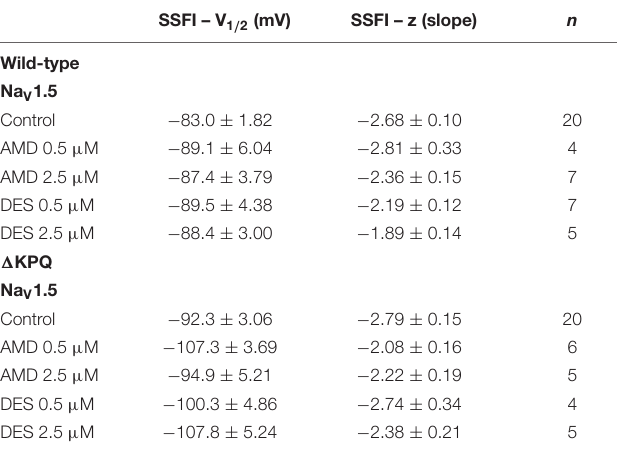
TABLE 3 | Steady-state fast-inactivation.